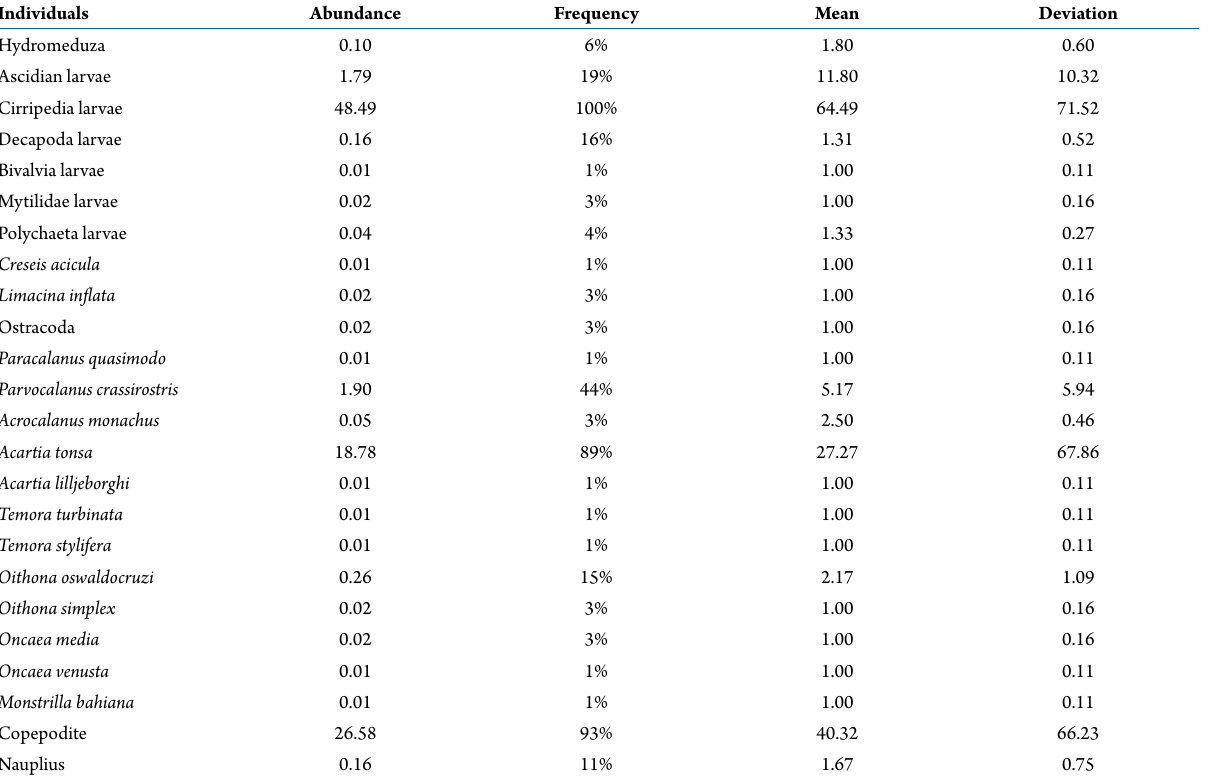
Figure 4. Temporal correlations between larvae of Cirripedia and Acartia tonsa (A) and between Acartia tonsa and temperature (B). Table 4. Relative abundance, frequency of occurrence, mean and standard deviation of all groups identified during the study